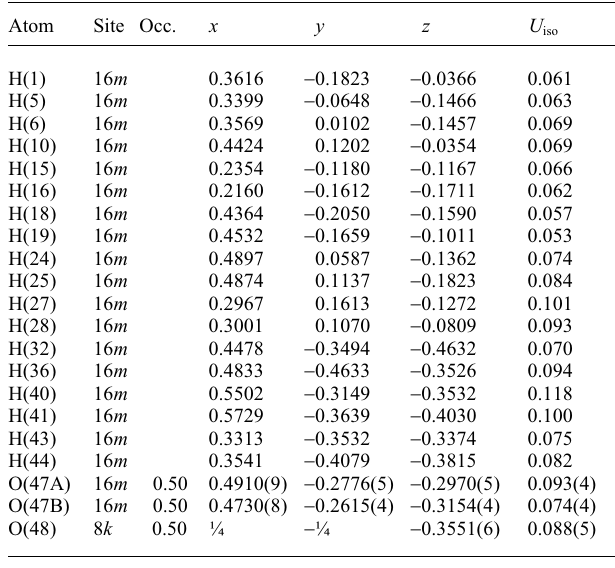
Table 2. Atomic coordinates and displacement parameters (in Å 2 ) .